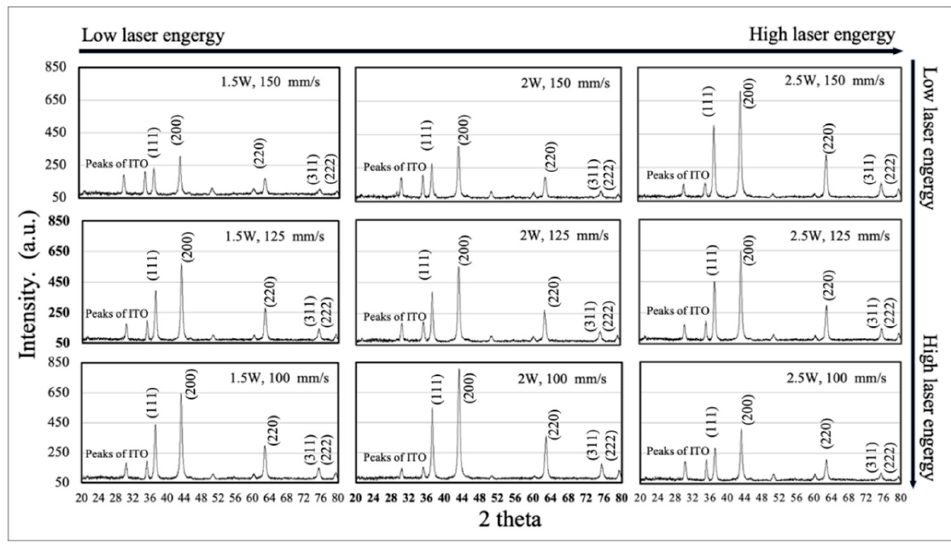
Figure 15. XRD patterns of sintered NiO thin films, which were sintered by different laser power outputs and scanning speeds. The results illustrated that there were no redox reactions in NiO, and unpredictable peaks.